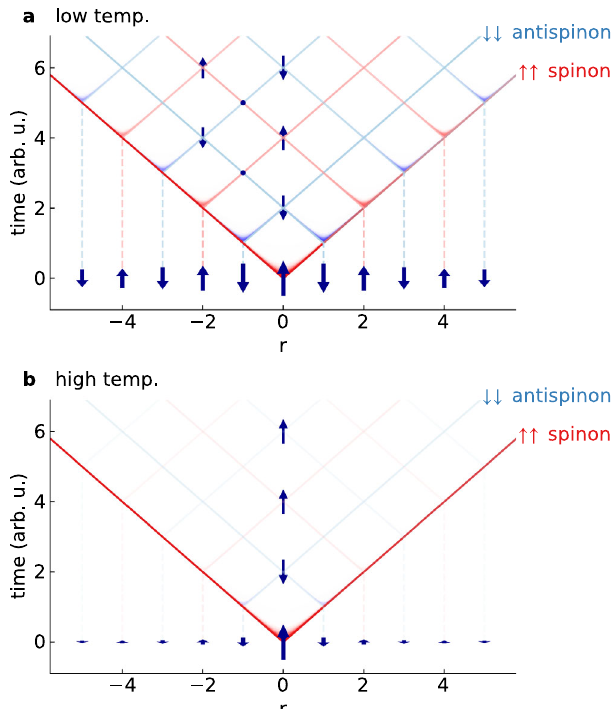
Fig. 4 | Schematic description of the AFM Van Hove correlations. At low tem- peratures, a acentralspinonlightconeemanatesfrom r =0, t =0.Asitreacheseach neighboring site, it excites a pair of (red) spinons which creates its own light cone. Odd neighbor sites have opposite spin from r =0 at t =0, and thus they create (blue)antispinonpairs.Lightconeshadingindicatesthestrength/coherenceofthe quantum correlations. For even r , these spinon light cones create constructive interference and continue to fl ip spins up and down. For odd r , the spinons and antispinonsdestructivelyinterfere,suchthatthecorrelationsquicklygotozero.At high temperatures b , the spin correlations are much weaker, such that the spinon and antispinon light cones emanating from ∣ r ∣ >0 are weakly coherent with r =0 and thus their in fl uence is suppressed, leading to oscillations restricted in both space in time as seen in Fig.